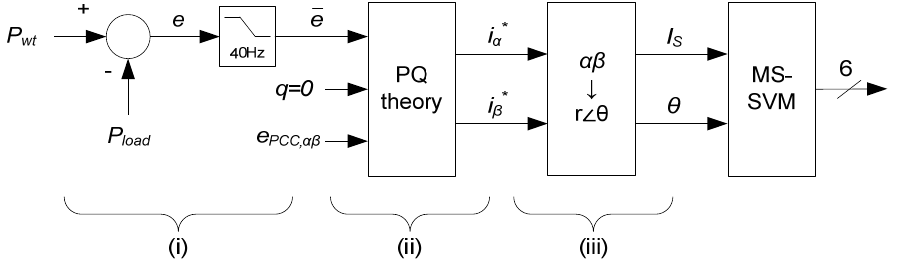
Figure 13. Block diagram of the reference current calculation and connection to the CSC